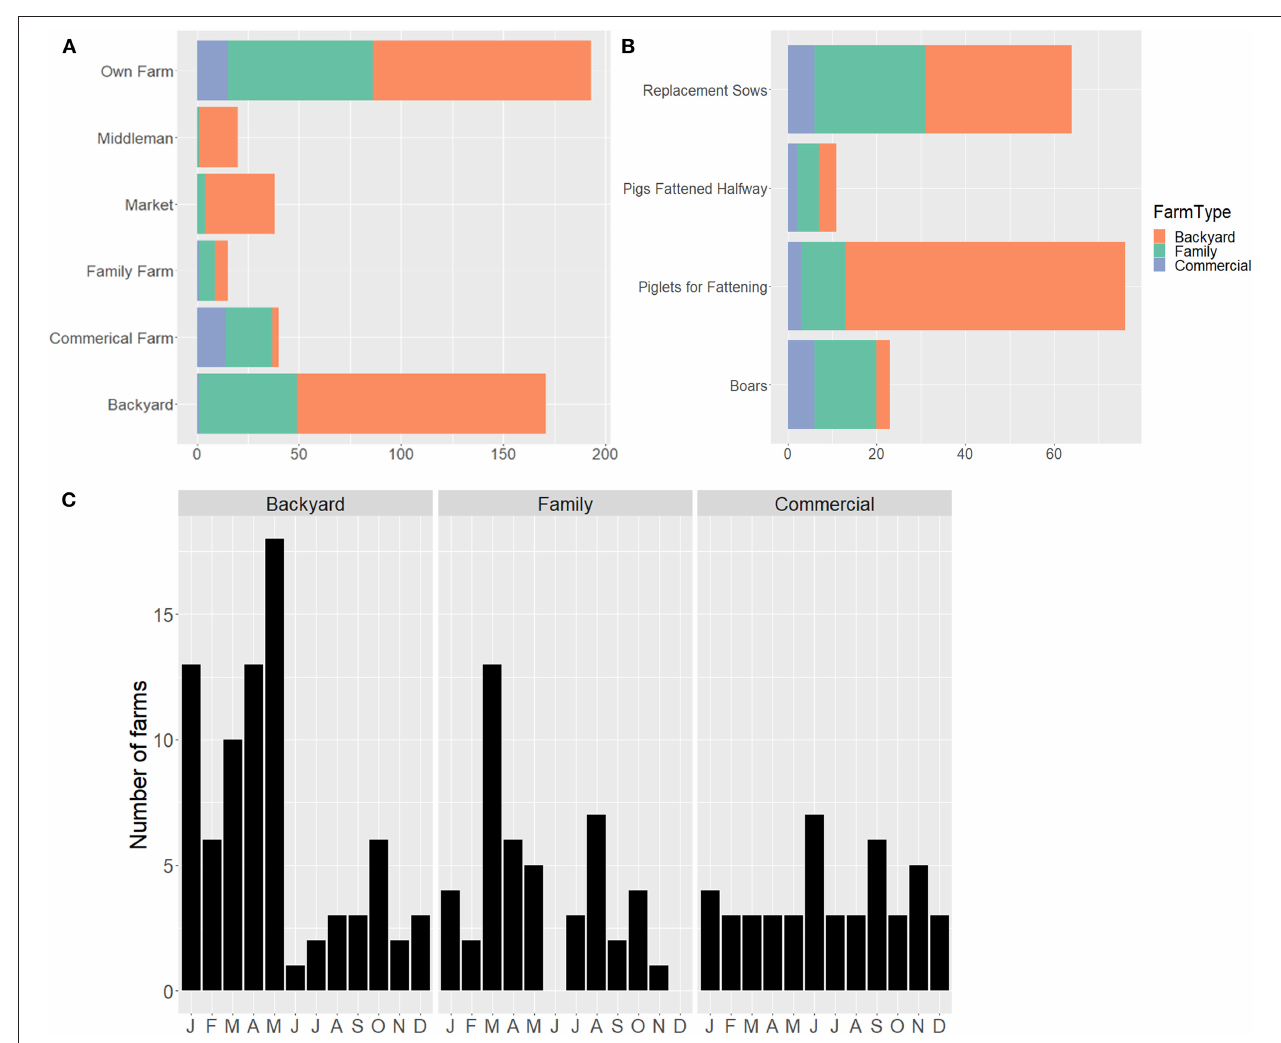
FIGURE 3 | North Macedonian producer’s pig buying practices by farm type by (A) source of pigs, (B) type of pig purchased, and (C) when pigs were purchased by month, based on questionnaires administered between September 2019-March 2020 (281 backyard, 146 family, and 30 commercial farms). Types of pigs: replacement sows = intact female pig for breeding; pigs fattened halfway = pigs over 25kg but under market weight; piglets for fattening: pigs from weaning to about 25kg; boar: intact male pig for